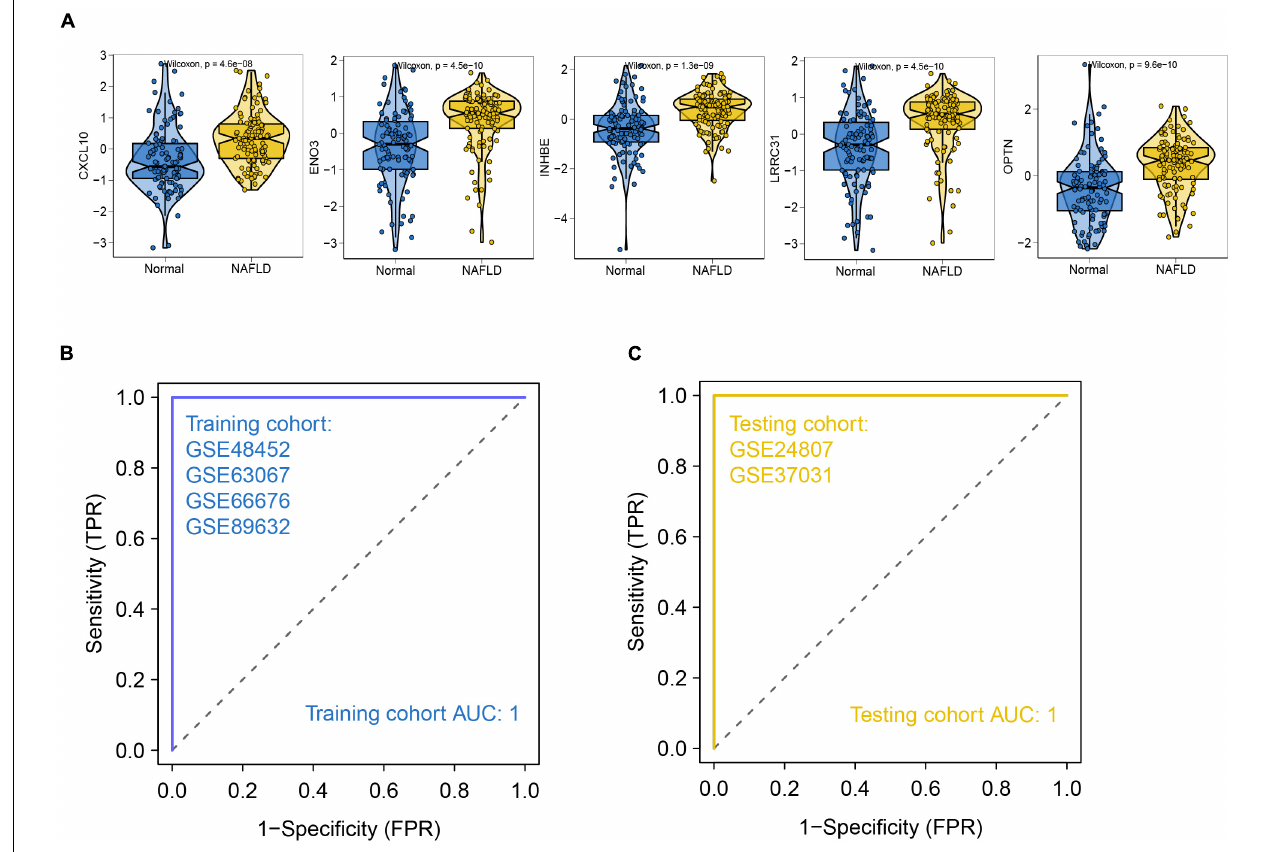
FIGURE 5 | Construction of NAFLD prediction model. (A) Expression pattern of the identified hub genes. (B) ROC of the training set. (C) ROC of the validation